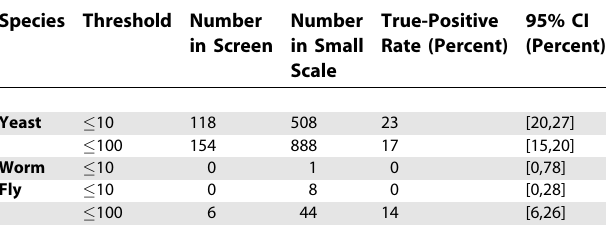
Table 10. True-Positive Rates Estimated from Literature Com- parisons Species Threshold Number